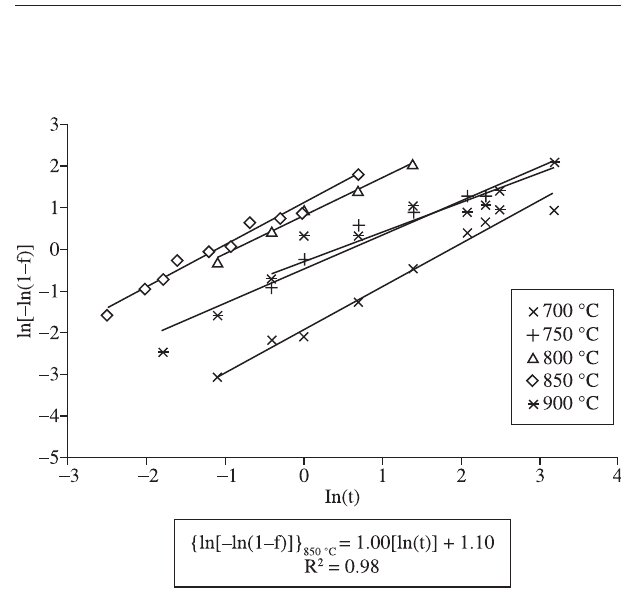
Figure 11. JMA plot of sigma phase formation from ferrite as a function of ln transformation time (hours) at each of five studied transformations. Linearity and high correlation factor (R² = 0.98 for 850 °C data is showed) indicates the same sigma phase formation mechanism in all studied transformation times at 850 °C.